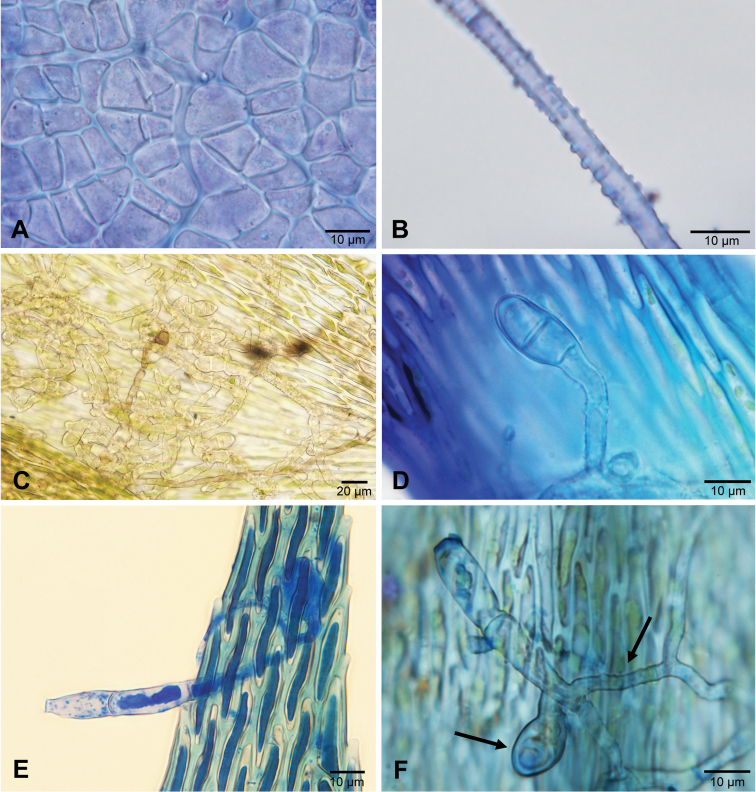
Microscopic characters of Octosporaconidiophora. A Cells of the outermost layer of excipulum from an outside view stained with CRBBMycelial hypha stained with CRBC Appressoria and hyphae on a leaf of Sematophyllumbrachycarpum in tap water D Appressorium stained with LACBE Germinating conidium stained with LPCBF Germinated conidium produced a bifurcate warted hypha (right arrow), appressorium (left arrow) probably not connected to the conidium, in LACBA, B, F ZE77/18 C, E ZE11/18 D holotype ZE48/18.